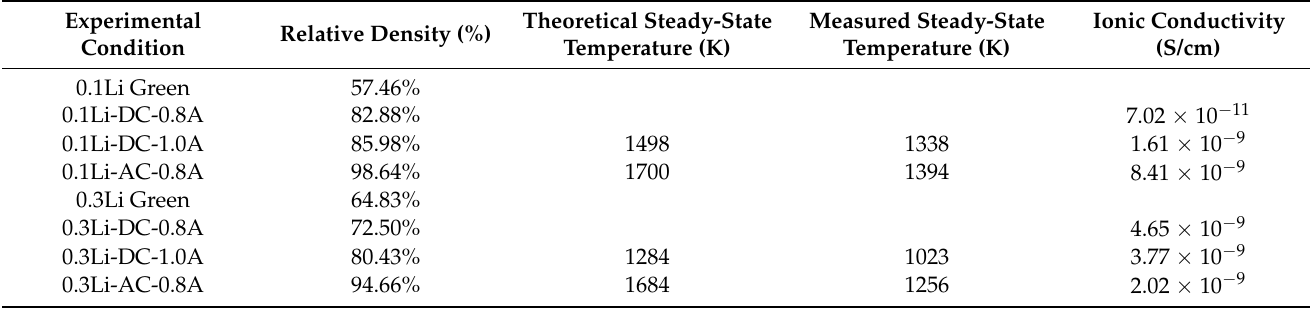
Table 2. Important parameters for specimens sintered under different conditions (Current values in “Experimental Conditions” represent the steady-state RMS currents during flash